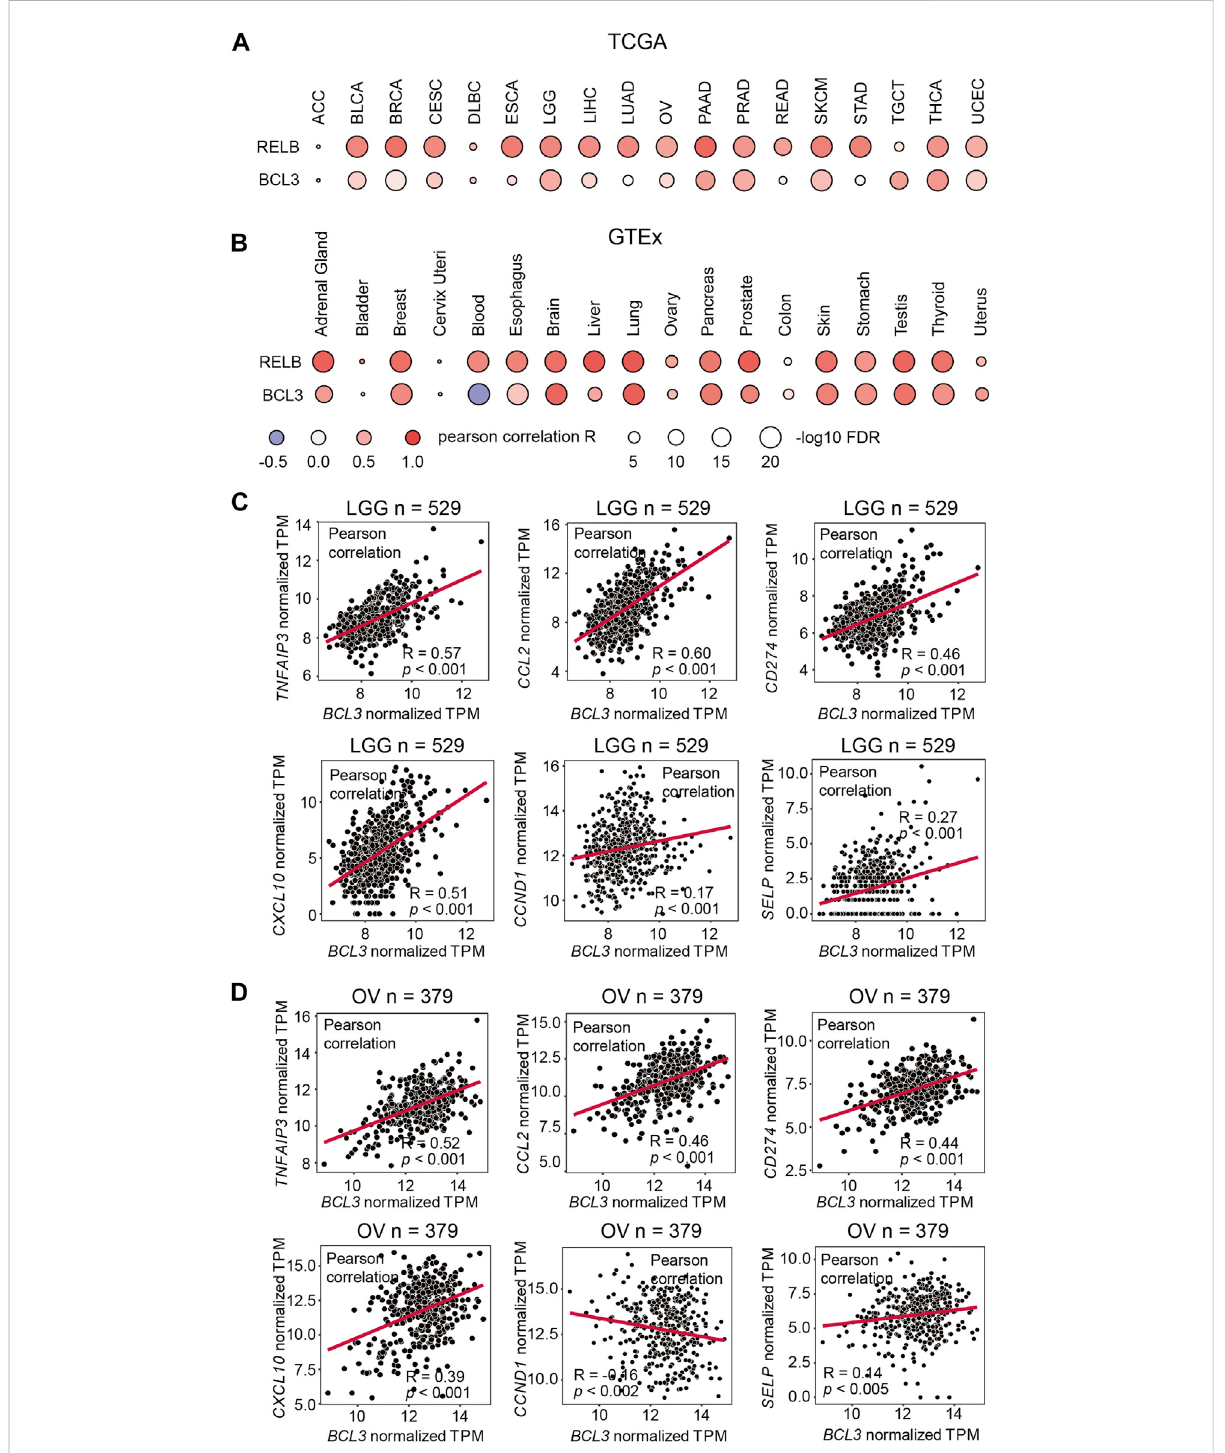
FIGURE 1 NFKB2 and RELB expressions are positively correlated. Correlation between NFKB2 , RELB, and BCL3 mRNA expressions in (A) various TCGA cancer types and (B) various GTEx tissue samples. Pearson correlation coef fi cient value (R) is shown by the blue-white-red color. R > 0 indicates the positive correlation; R < 0 indicates the negative correlation. The size of circles represents the values of log10 FDR. The abbreviation of each TCGA cancer type is listed on the following website: https://gdc.cancer.gov/resources-tcga-users/tcga-code-tables/tcga-study-abbreviations. ScatterplotsshowingthecorrelationbetweenmRNAexpressionsof BCL3 andp52:p52:Bcl3targetgenes( TNFAIP3 , CCL2 , CD274 , CXCL10 , CCND1 , and SELP ) in (C) brain lower grade glioma (LGG) and (D) ovarian serous cystadenocarcinoma (OV) from TCGA database. “ n ” denotes the sample